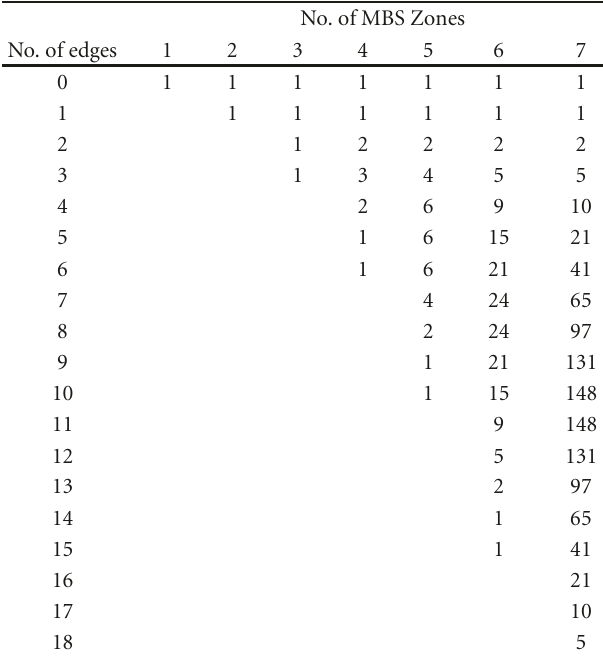
Table 1: The number of nonisomorphic graphs for a given number of MBS Zones with di ff erent